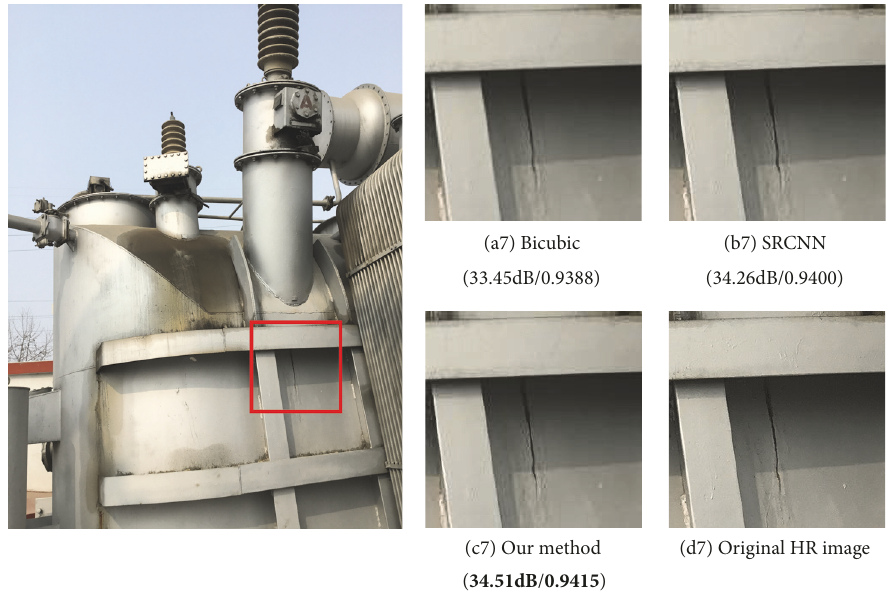
Figure 11: Cracks on the body of transformer.